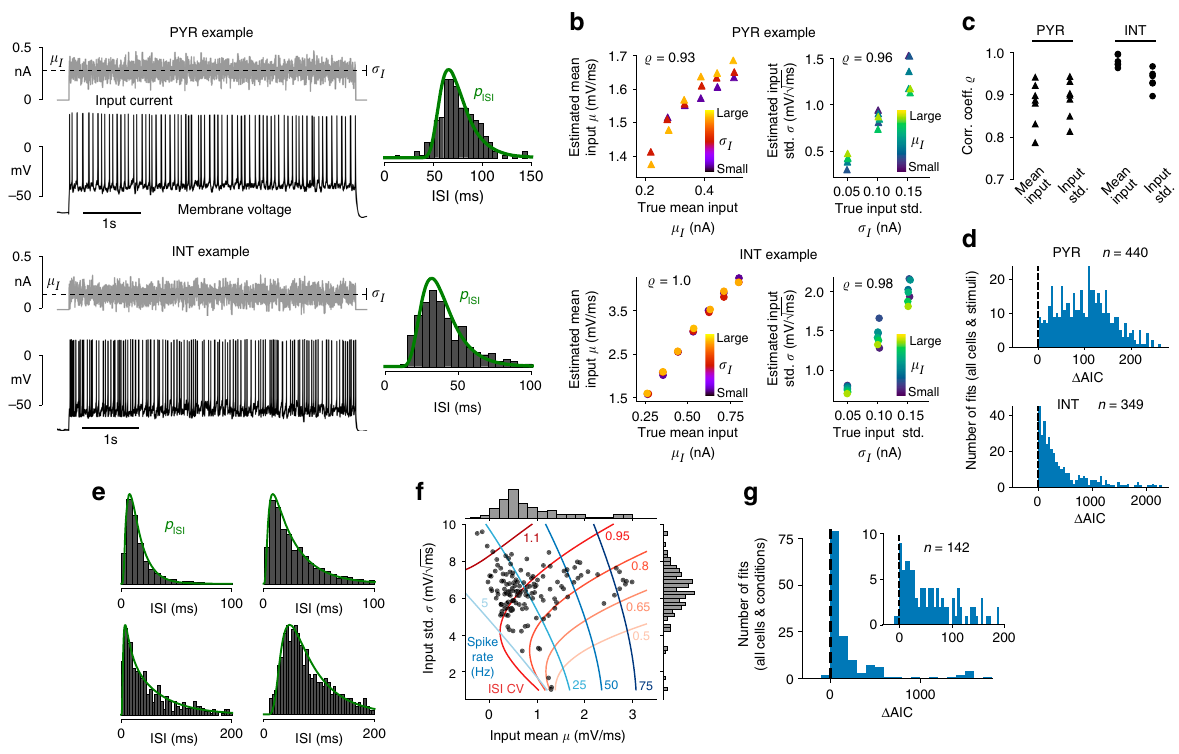
Fig. 2 Estimation results for background input statistics using in vitro and in vivo data. a Examples of recorded membrane voltage in response to fl uctuating input with indicated mean μ I and standard deviation σ I (vertical bar marks μ I ± σ I ) together with ISI histogram and density p ISI that corresponds to the fi tted leaky I&F model for a PYR (top) and an INT (bottom). Method 1 was used for parameter estimation. b Estimated input parameters ( μ , σ ) versus empirical input statistics ( μ I , σ I ) with Pearson correlation coef fi cient ϱ indicated for an example PYR and INT each. Note that since we considered only spikes, and not the membrane potential, we did not estimate the input resistance and rest potential; therefore, the input parameters were de fi ned up to arbitrary offset and scale factors. c ϱ for input mean and standard deviation for all seven PYRs and six INTs. d Histograms of AIC difference ( Δ AIC) between the Poisson and I&F models across all stimuli for all PYRs (top) and all INTs (bottom). e Examples of ISI histograms from in vivo recordings and densities p ISI from fi tted I&F neurons. f Estimates of parameters for the background input together with contour lines of equal spike rate and ISI CV calculated from p ISI . g Histogram of AIC difference between the Poisson and I&F models across all cells and conditions